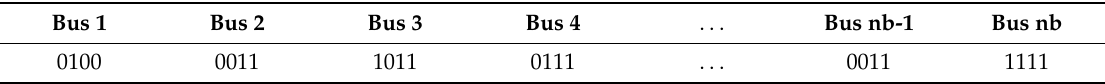
Table 2. Solution candidates